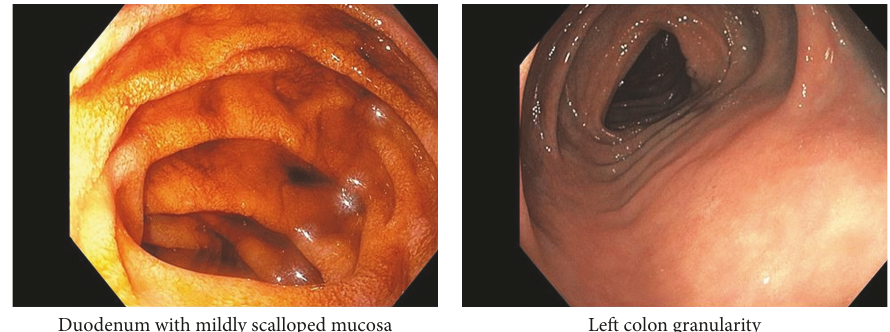
Figure 2: Localized mildly scalloped mucosa in the 2nd portion of the duodenum and granularity in the left colon.